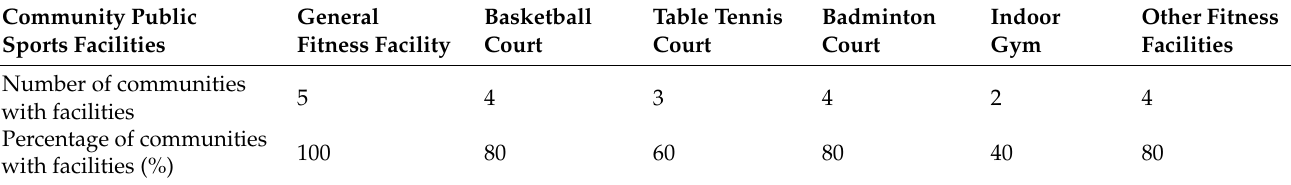
Figure 3. Distribution of the number of people surveyed for exercise time. Table 1. Current status of supply of community public sports facilities.